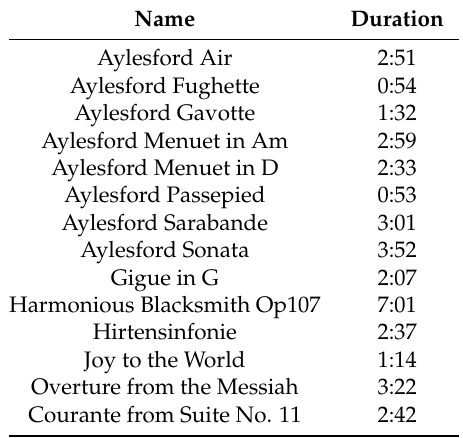
Table 1. Information about the compositions used in this